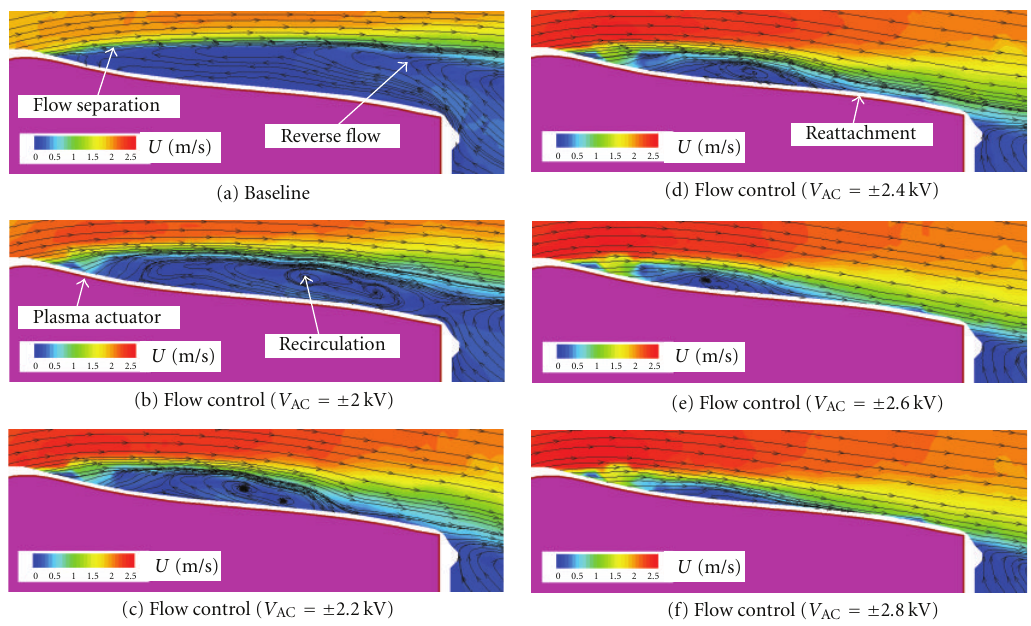
Figure 7: Time-averaged absolute velocity distributions and stream lines near curved wall at various DBD-PA input voltages.